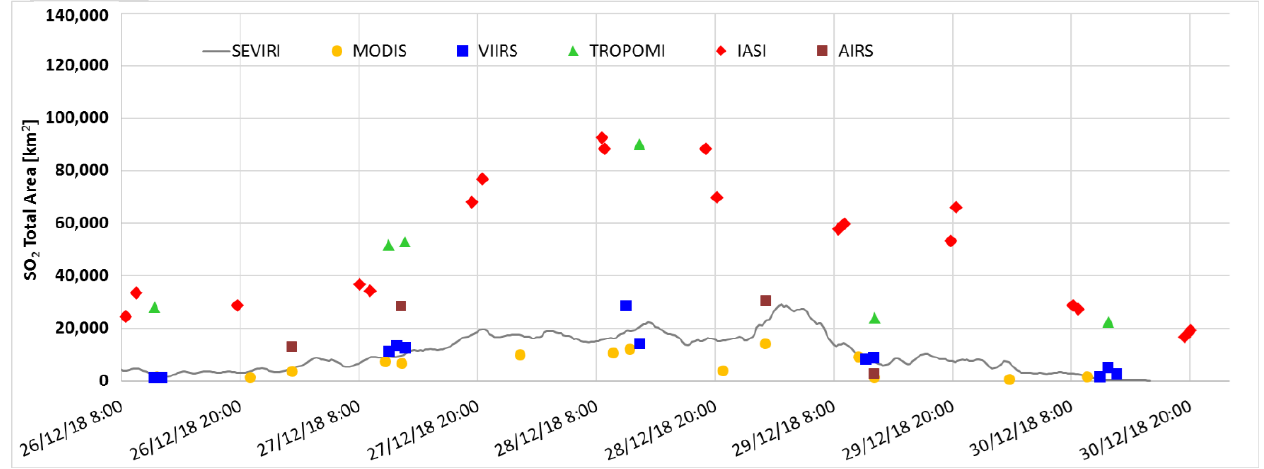
Figure 6. SO 2 total area computed from the images collected by the different satellite instruments in the latitude–longitude grid 34–38N, 14–18E.